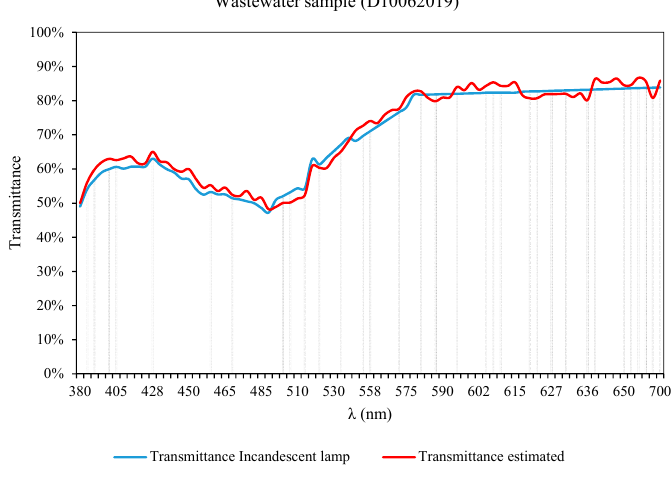
Figure 21. Wastewater sample analysis (D10062019).